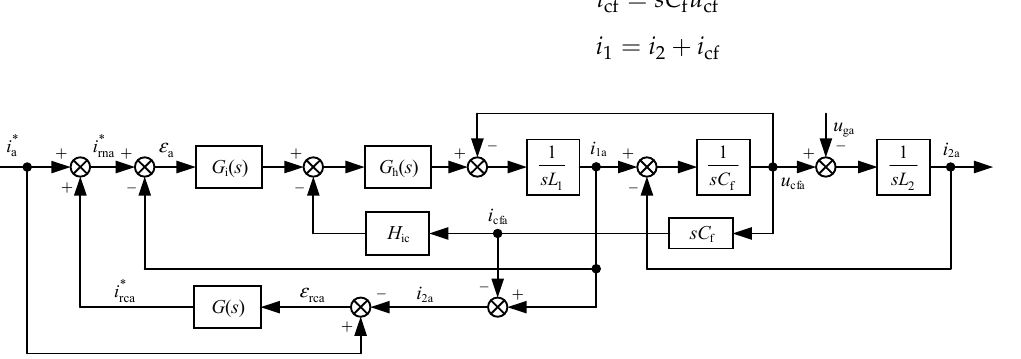
Figure 4. Control block diagram of optimized indirect current control with reference current compensation.